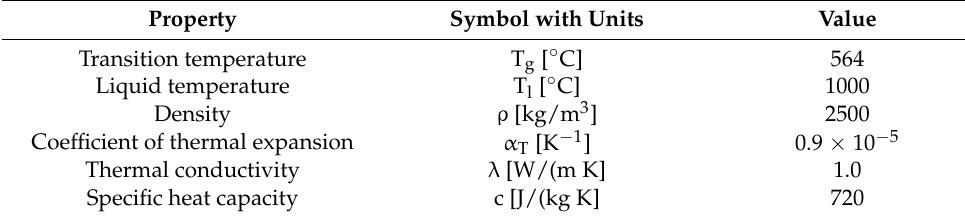
Table 3. General physical properties of soda-lime-silica glass [35].